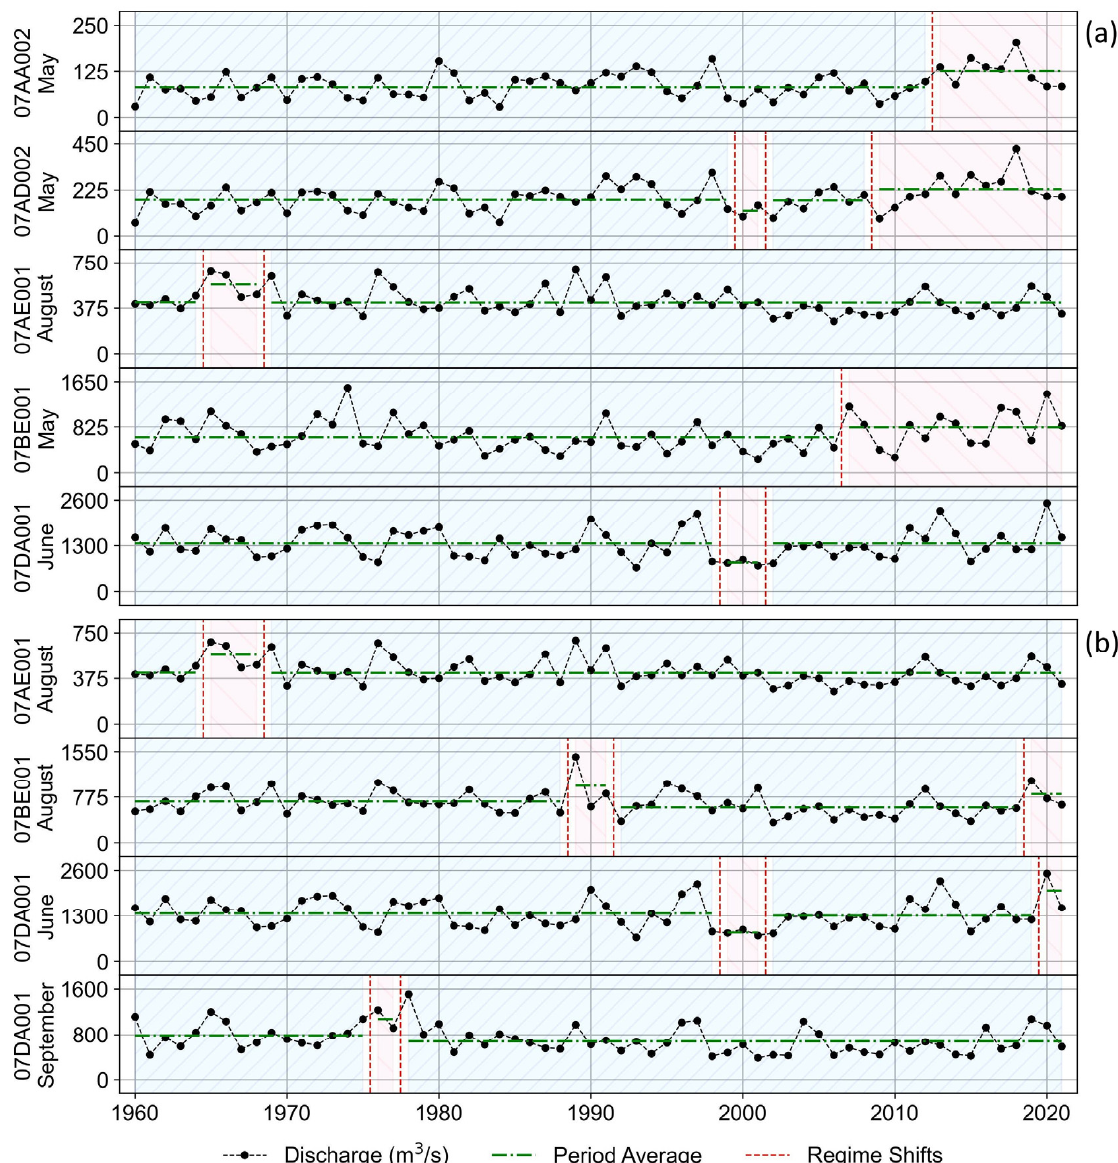
Figure 5. RSCD Results for warm months using Growth Rate ( a ), Relative Difference ( b ), and a 30-year (1961–1990) period for calculating µ and σ , and ε thresholds from Table 2. The streamflow (m 3 /s) is shown on the y -axis in each panel. The use of red and blue shades aids in distinguishing between the di ff erent regimes.